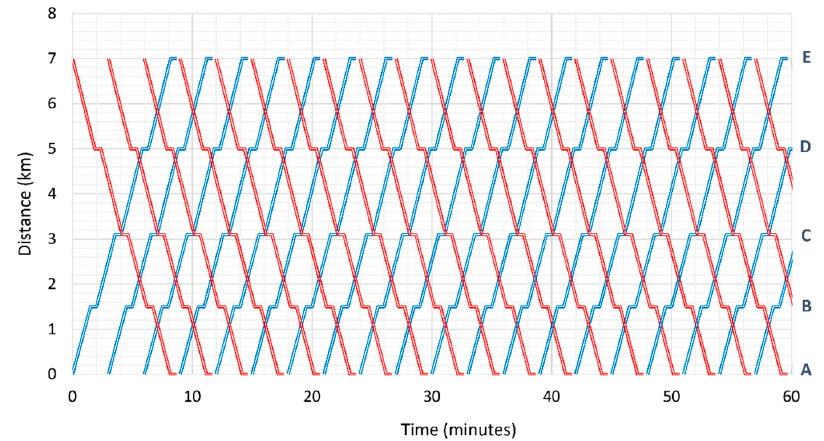
Figure A3. Simulation of 1 h tram operation between station A and B and return (3 min headway, 30 s dwell time).